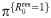
Incidence of gonorrhoea in 2015 based on simulations from 2004 to 2015 with varying levels of cefixime prescribing.(A) Incidence of the cefixime-resistant strain. The red lines show the 95% credible interval for π{R0res=1}. (B) Incidence of the cefixime-susceptible strain. The red lines show the 95% credible interval for π{R0sus=R0res}. (C) The overall incidence from both cefixime-resistant and cefixime-susceptible strains. The shaded areas show the 95% posterior predictive intervals (based on 1,000 simulations using samples from posterior distribution).